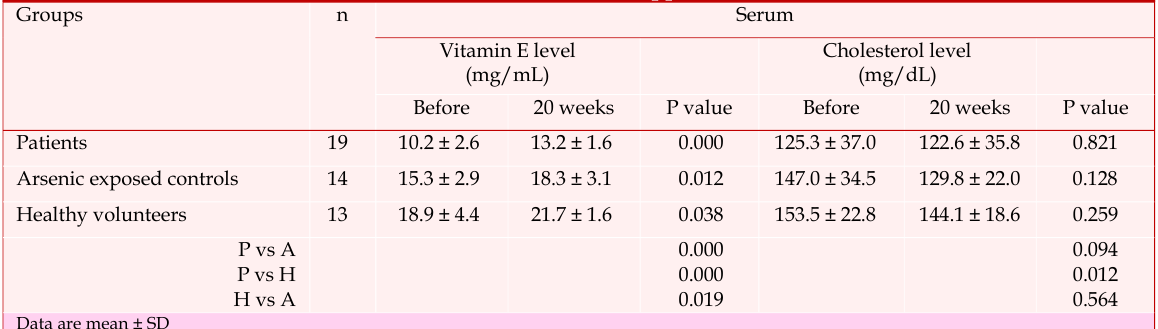
Vitamin E and cholesterol levels in serum of patients, arsenic exposed controls and healthy volunteers both before and after vitamin E